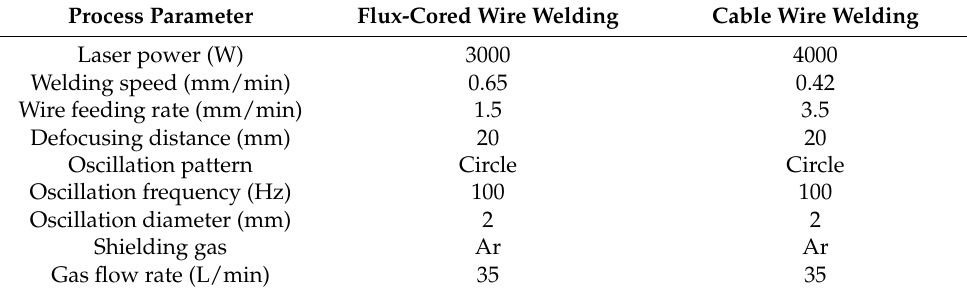
Figure 2. Schematic diagram of the welding process. Table 2. Welding parameters.